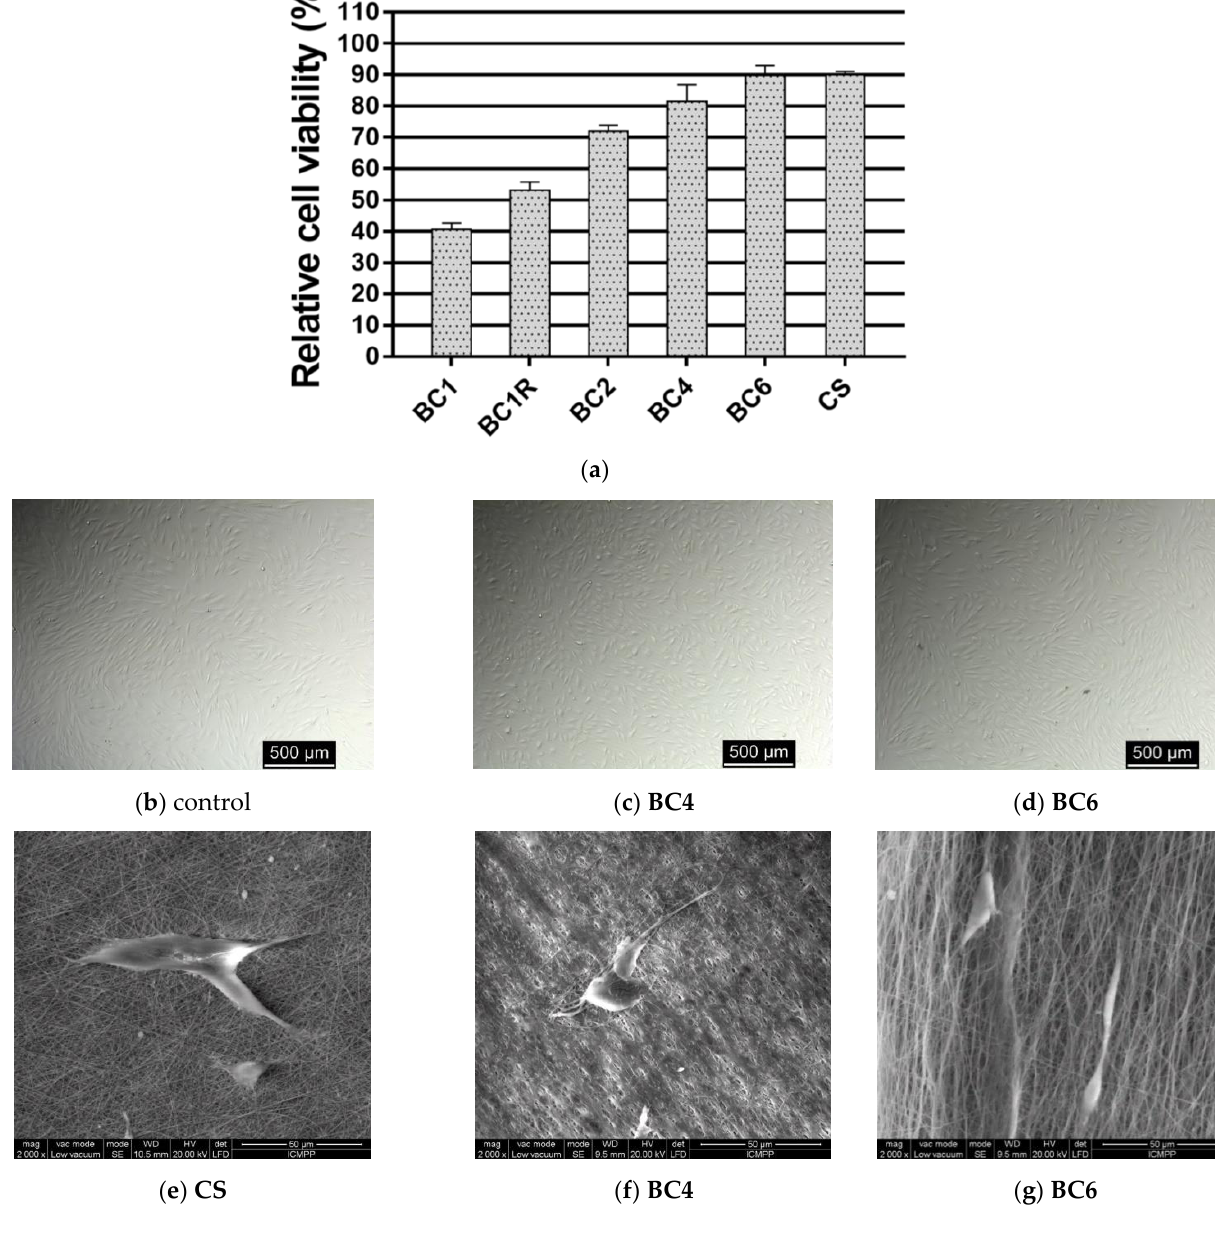
Figure 11. ( a ) Relative cell viability of NHDF cells (The results are presented as means ± S.E.M. (standard error of the mean), n = 9); ( b – d ) Representative brightfield microscopy images of the NHDF cells exposed for 24 h to the fiber mats; ( e – g ) Representative SEM images of NHDF cells attached to the nanofiber mats, after 24 h of incubation.